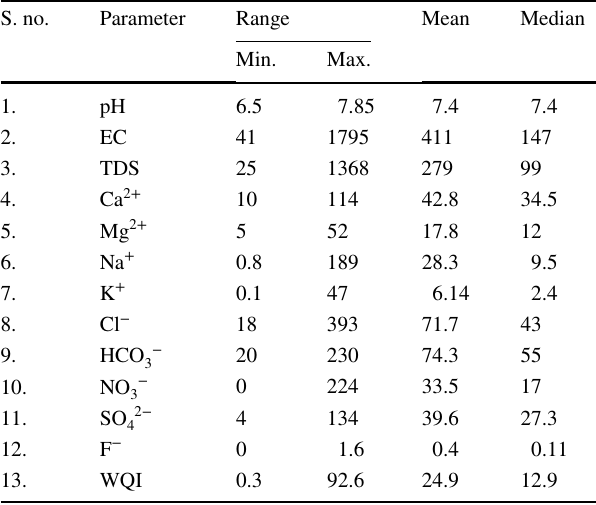
Table 2 Statistical summary of the hydrochemical parameters of water in the study area